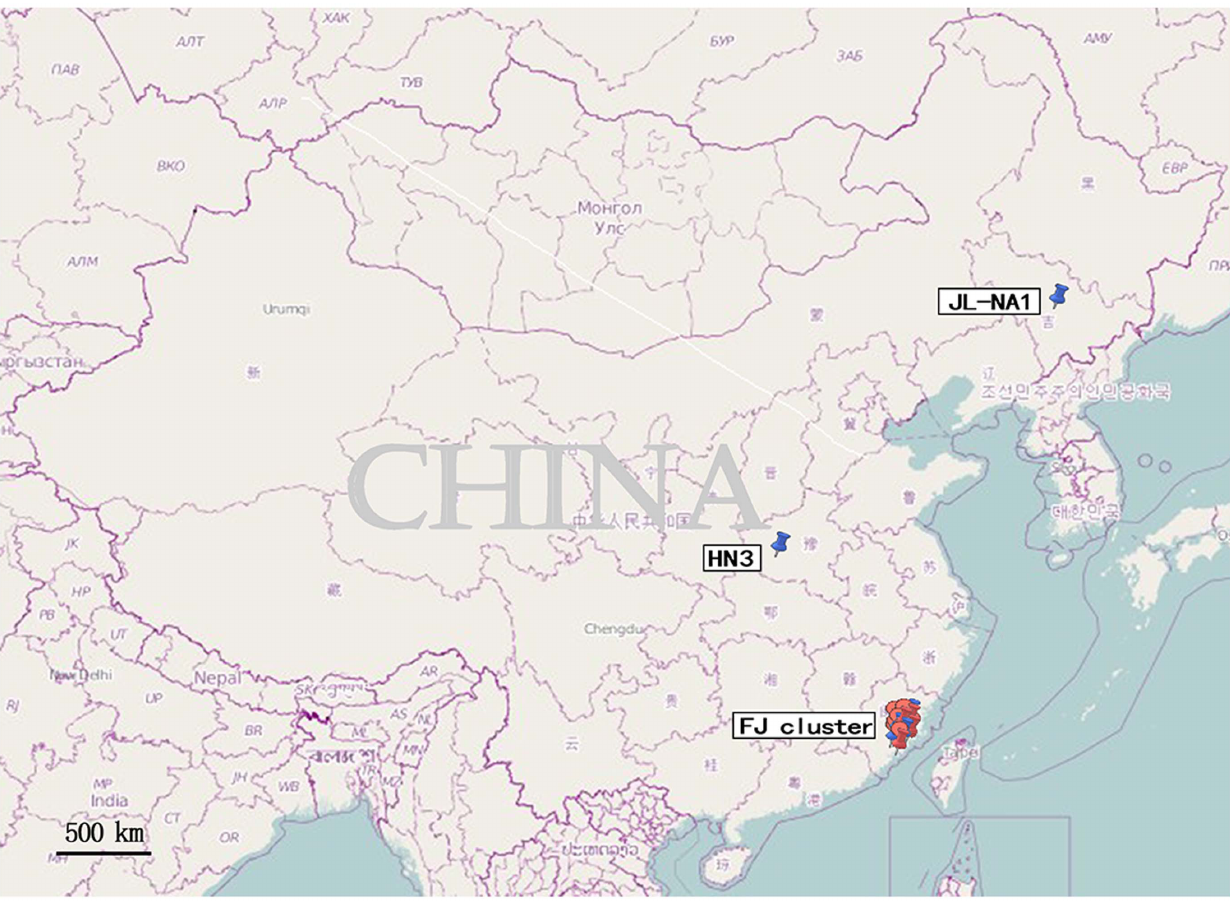
Figure 2. Sites in China at which orf isolate sequences of ORFV011 and ORFV059 genes were used for phylogenetic analysis. The following link is for Fig.2: http://www.openstreetmap.org/